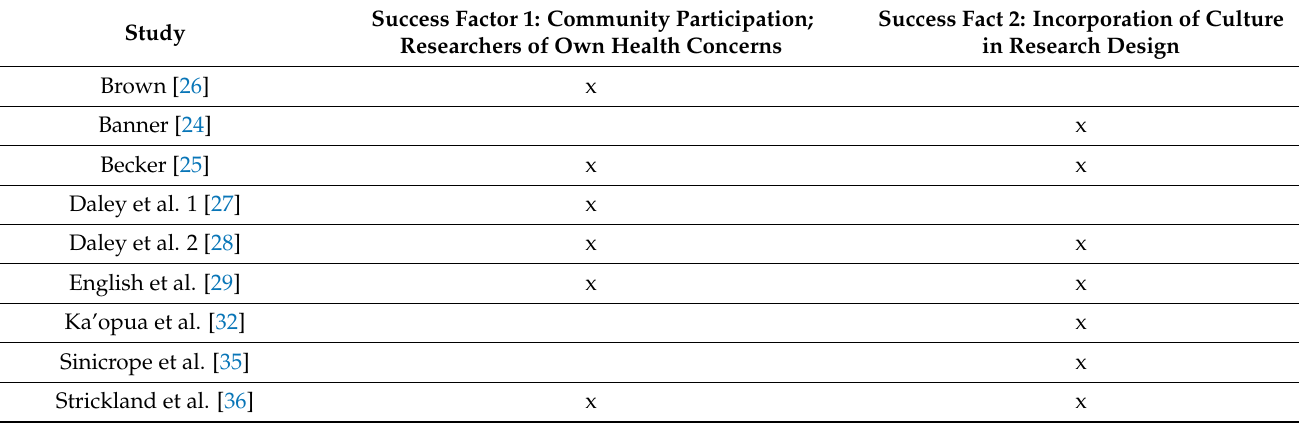
Table 4. The two most common engagement